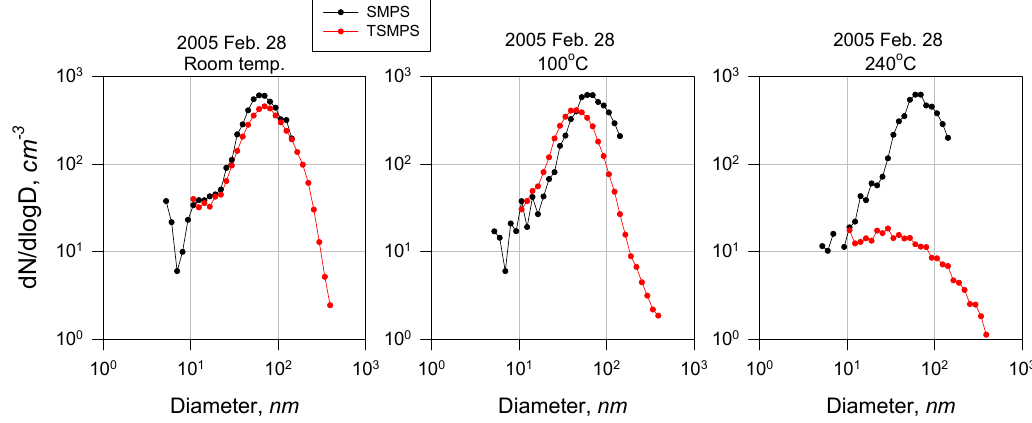
Fig. 3. Typical examples of aerosol size distribution measured on 28 February 2005 at Syowa Station, Antarctica under the conditions of room temperature (ca. 20 ◦ C), 100 ◦ C and 240 ◦ C.